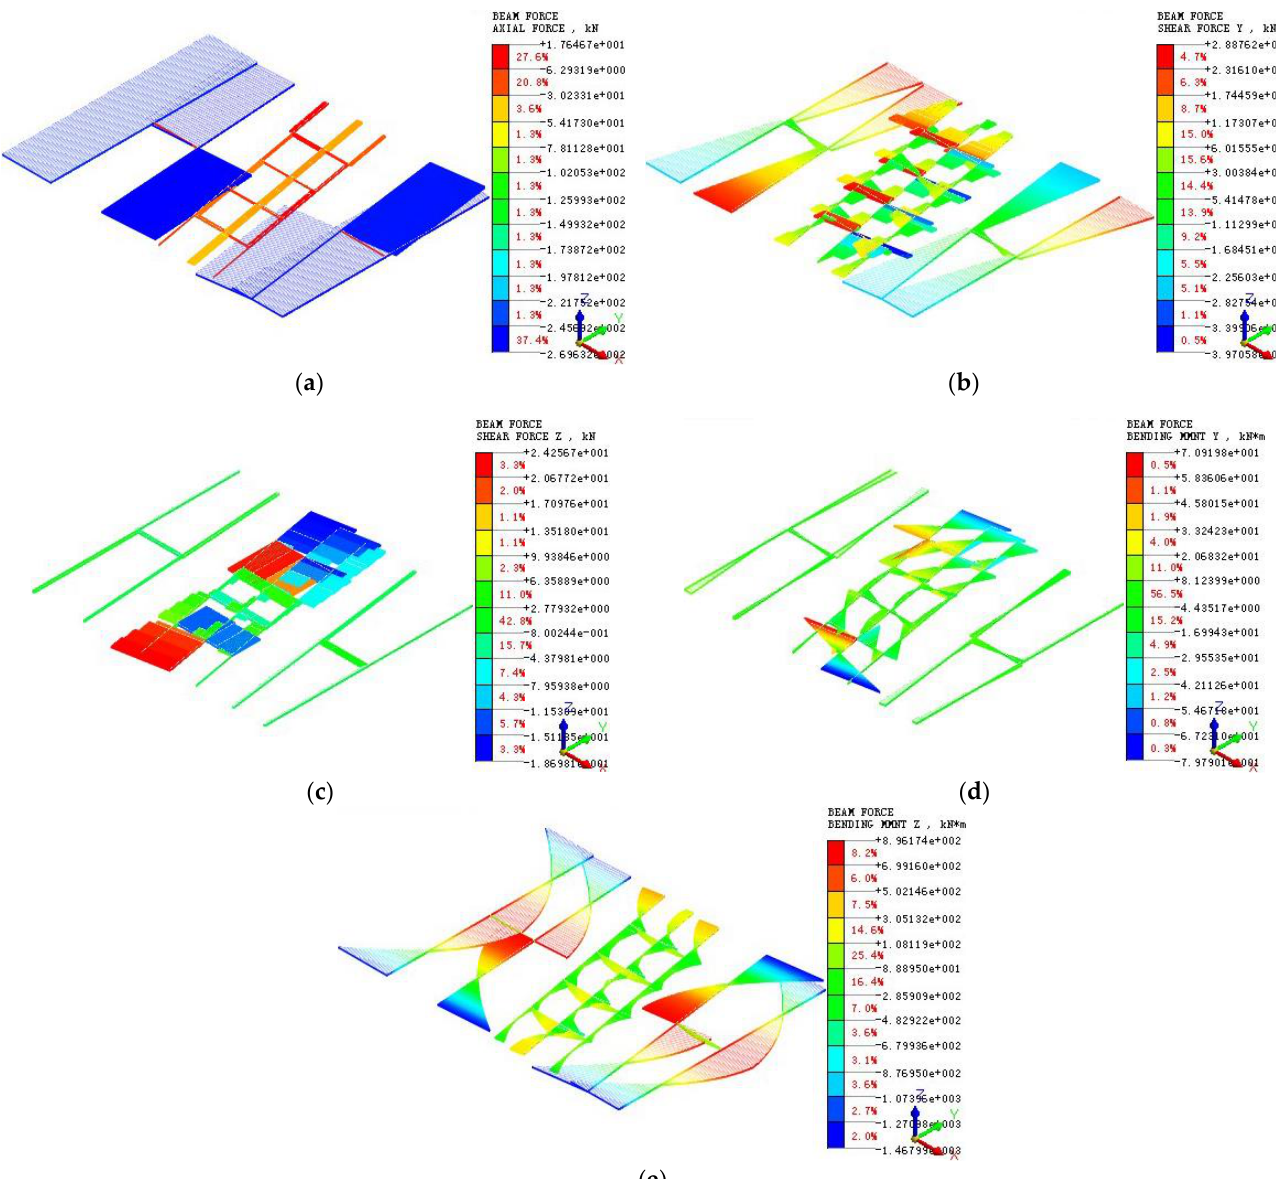
Figure 10. Contours of internal forces in concrete strut at Excavation Step 8: ( a ) Axial force; ( b ) Shear force in Y direction; ( c ) Shear force in Z direction; ( d ) Bending moment in Y direction; ( e ) Bending moment in Z direction.